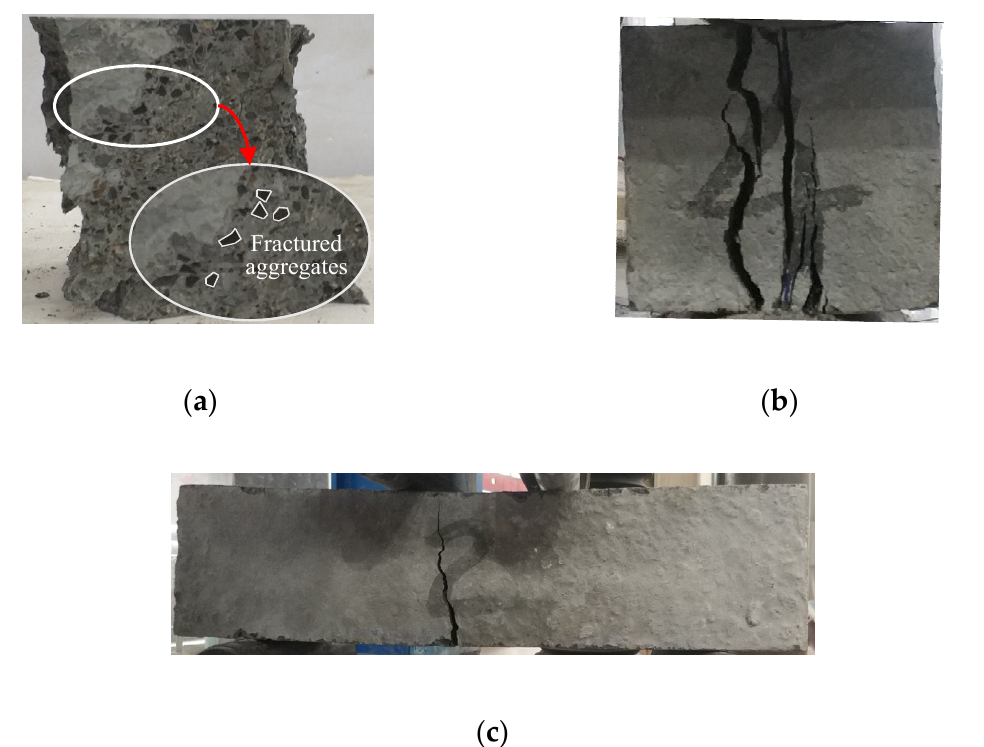
Figure 1. Failures of specimens for compression, splitting tensile and flexural tests-( a ) typical failure of compressive strength tests; ( b ) typical failure of specimens in splitting tensile test; ( c ) typical failure of specimens in flexural